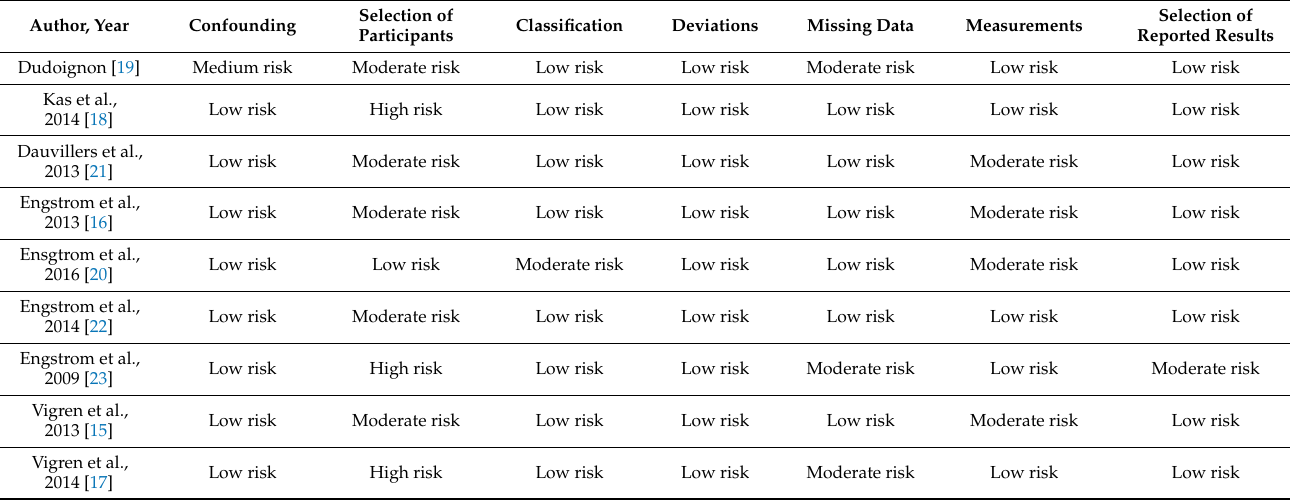
Table 4. The bias analysis of the systematic